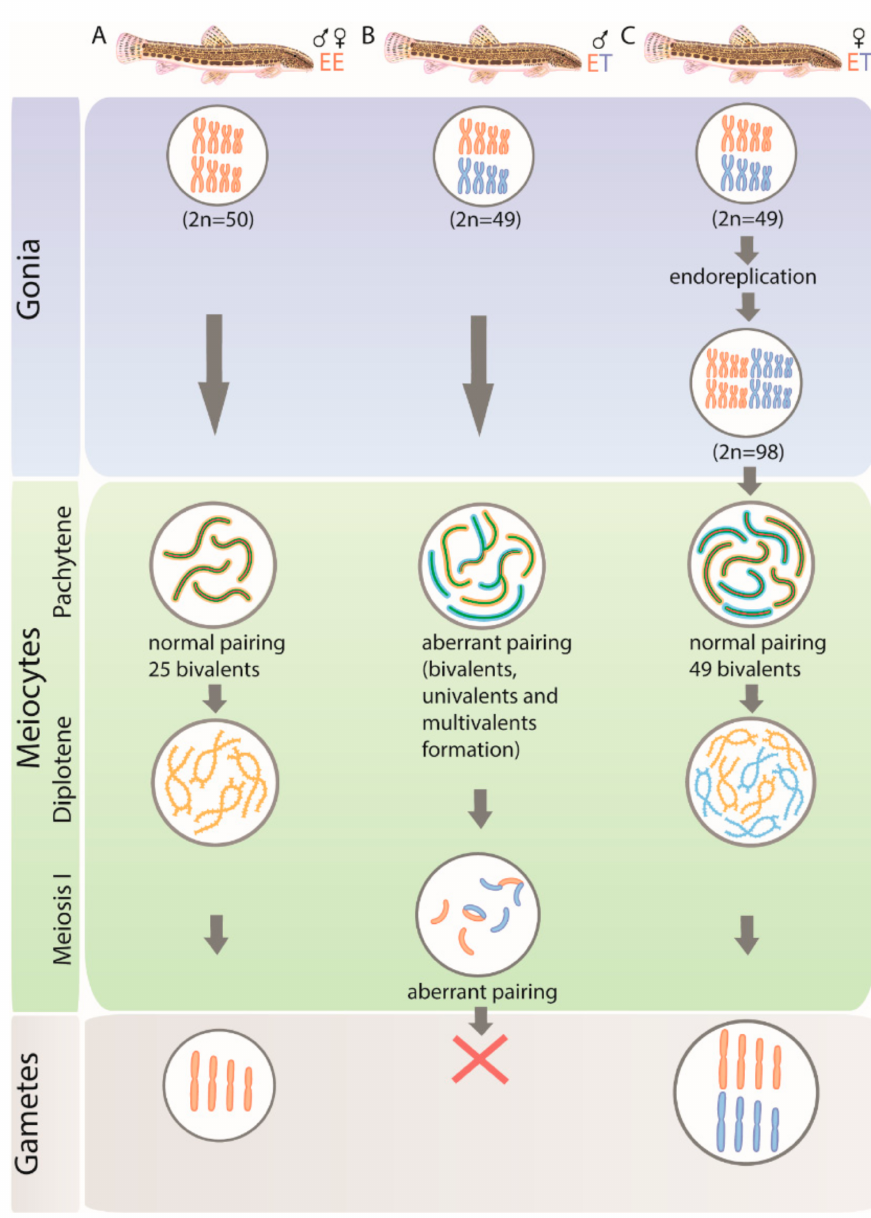
Figure 1. Schematic overview of gametogenic pathway during sexual reproduction ( A ), hybrid sterility ( B ) and asexuality ( C ). Each column shows individuals, gametogenic pathways with the indication of the germ cells, cells in two meiotic stages (pachytene and diplotene) and gametes. ( A ) (Orange chromosomes), ( B ) (blue chromosomes) indicates genomes of different parental species, C. elongatoides and C. taenia , correspondingly. ( A ) During sexual reproduction, gonia cells enter meiosis, which results in a haploid egg. Homologous chromosomes are joined by the synaptonemal complex (green color indicates the lateral element of synaptonemal complexes; red color indicates the central element of synaptonemal complexes) during pachytene, which is disassembled by the diplotene stage of meiosis. ( B ) Hybrid sterility caused by aberrant chromosome pairing during pachytene (also see [25]). ( C ) Reproduction of asexual hybrids is realized by endoreplication of the genomes in gonial cells allowing bivalent formation between identical chromosomal copies resulting in diploid gamete formation (modified from